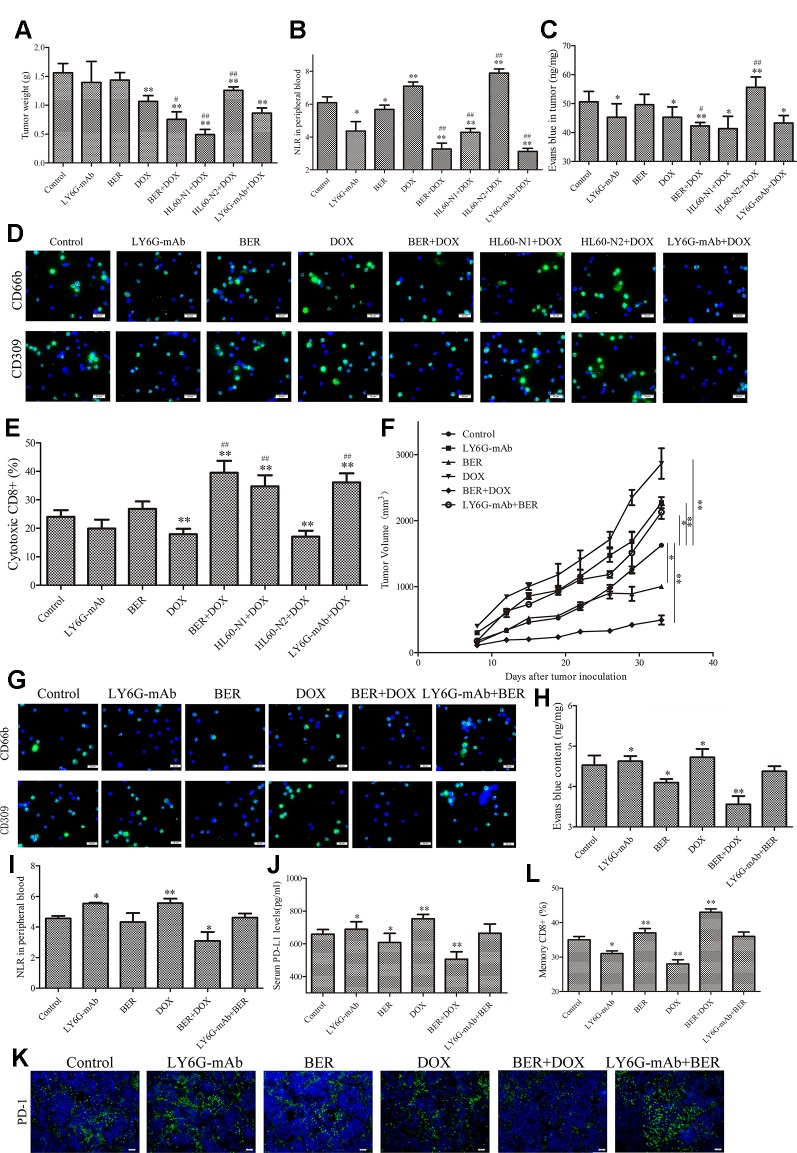
N2-like neutrophils are related to tumor sensitivity to DOX and tumor secondary immunity and immune memory. (A) Tumor weight (n = 6). (B) Tumor tissue permeability to Evans blue (n = 6). (C) Neutrophil to lymphocyte ratio (NLR) in peripheral blood in tumor-bearing mice (n = 6). (D) Bone marrow neutrophil immunophenotypes indicated by immunofluorescence (n = 6, 40×). (E) Spleen cytotoxic CD8+ cell rate (n = 6, 40×). (F) Tumor growth curve in a tumor rechallenge immune study. (n = 6). (G) Bone marrow neutrophil immunophenotypes indicated by immunofluorescence (n = 6, 40×). (H) Tumor tissue permeability to Evans blue (n = 6). (I) NLR in peripheral blood (n = 6). (J) Serum PD-L1 levels (n = 6). (K) Spleen tissue PD-1 expression indicated by immunofluorescence. (n = 5, 40×). (L) Spleen memory CD8+ cell rate (n = 6). The data present mean ± SD, the experiments were repeated three times, and statistical significance was determined by a t-test. *P < 0.05, **P < 0.01 vs. control; #P < 0.05, ##P < 0.01 vs. DOX. DOX, doxorubicin; BER, berberine.